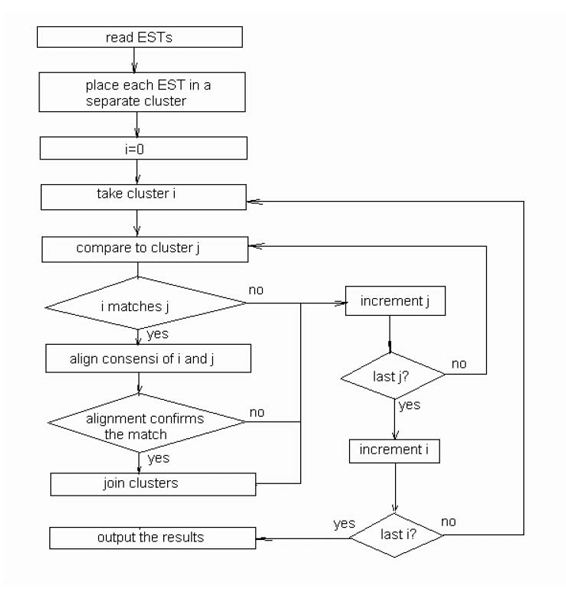
Basic algorithms of the CLU clustering program.